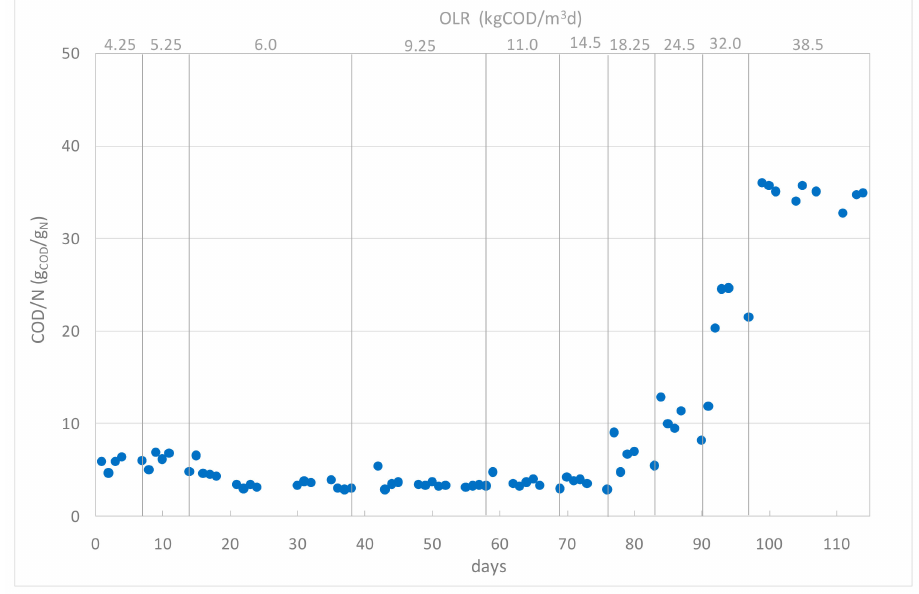
Figure 6. COD / N ratio over the pilot plant operational